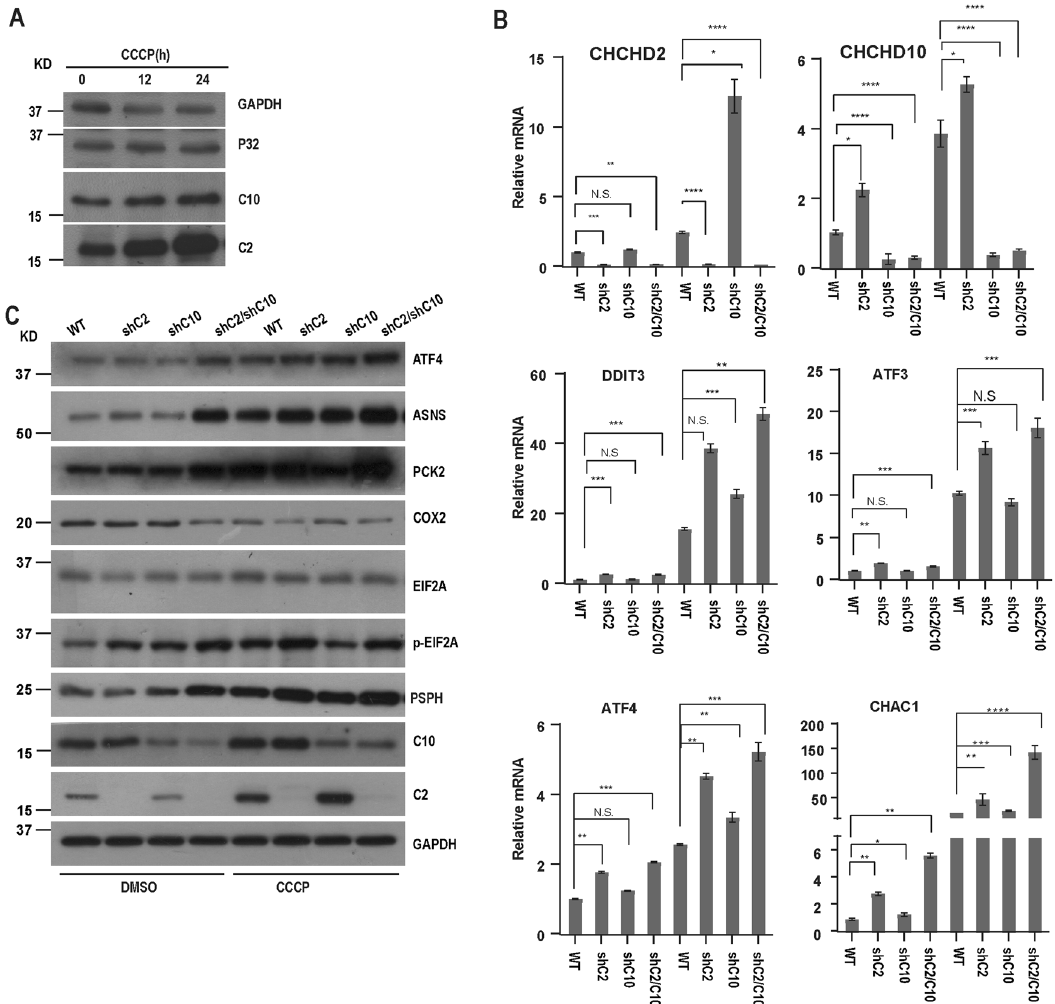
Fig. 2 Loss of CHCHD2 and CHCHD10 promotes mitochondrial integrated stress response. A Whole-cell lysates of HeLa cells treated with DMSO or CCCP (10 mM, 12 h, or 24 h) respectively were analyzed for indicated protein expression by immunoblot. GAPDH was used as a loading control. B HeLa cells were infected with control, shCHCHD2, shCHCHD10, shCHCHD2/CHCHD10 lentiviral particles respectively and cultured for 7 days, treated with CCCP (10 mM) for 24 h, and then relative transcript levels of the indicated gene was analyzed by